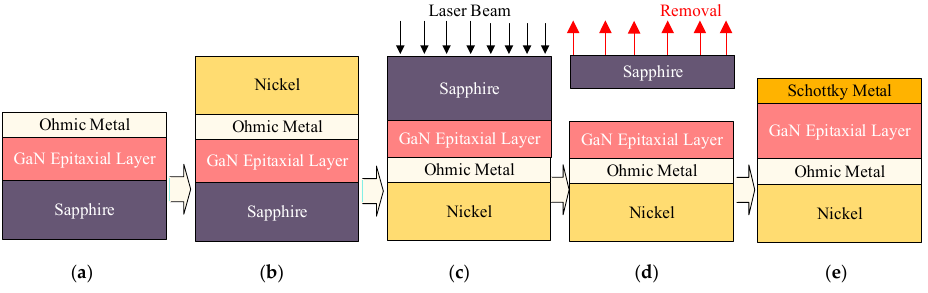
Figure 11. Vertical GaN SBD device process flowchart: ( a ) ohmic contact, ( b ) nickel electroplating, ( c ) laser lift-off, ( d ) sapphire removal, and ( e ) Schottky contact.